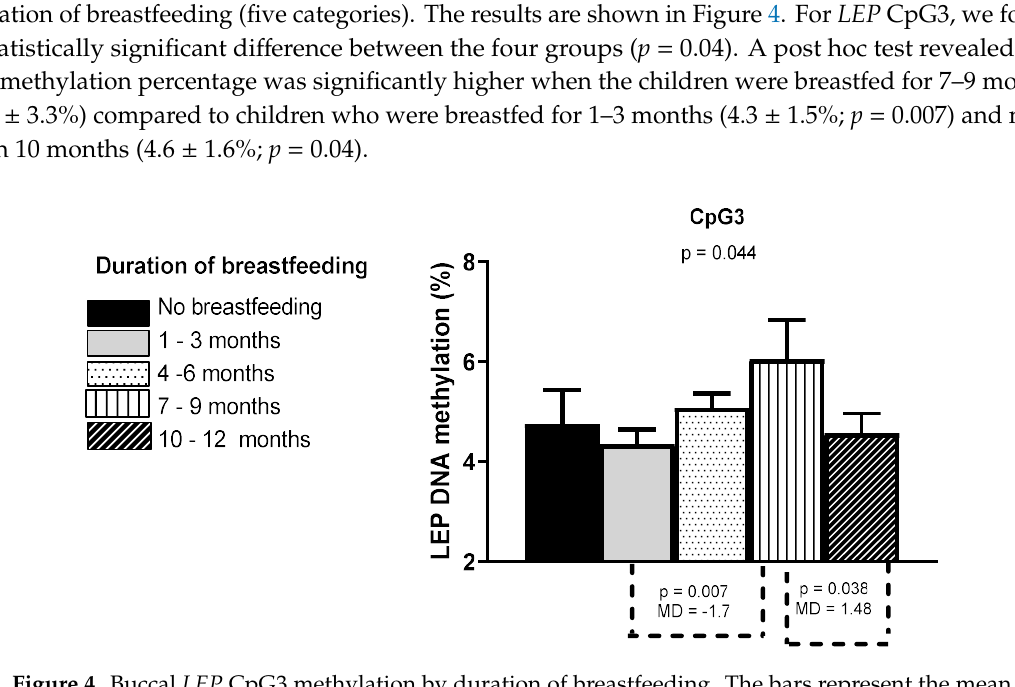
Figure 4. Buccal LEP CpG3 methylation by duration of breastfeeding. The bars represent the mean methylation values and standard errors of the mean of the 93 one-year-olds. The results are based on the duration (five categories) of maternal breastfeeding. The overall p -values (one-way ANOVA) and significant p -values with mean differences from post hoc tests are shown.